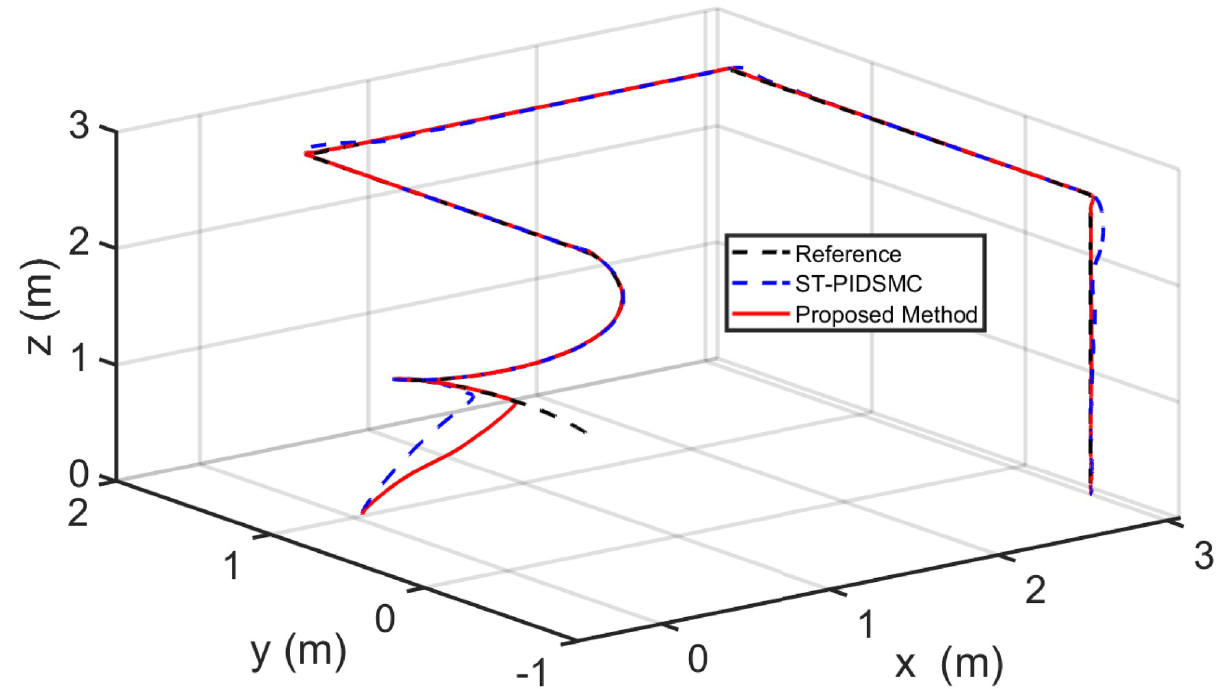
Fig 11. Results of the path following in 3D space under the proposed